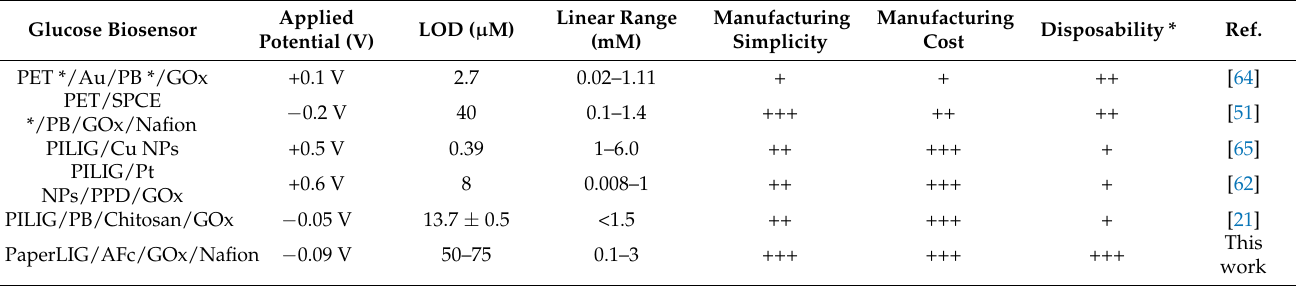
Table 2. The comparison of PaperLIG-based glucose biosensors with other kinds of glucose biosen- sors. A great number of + signs indicate a higher evaluation for the corresponding parameter of the